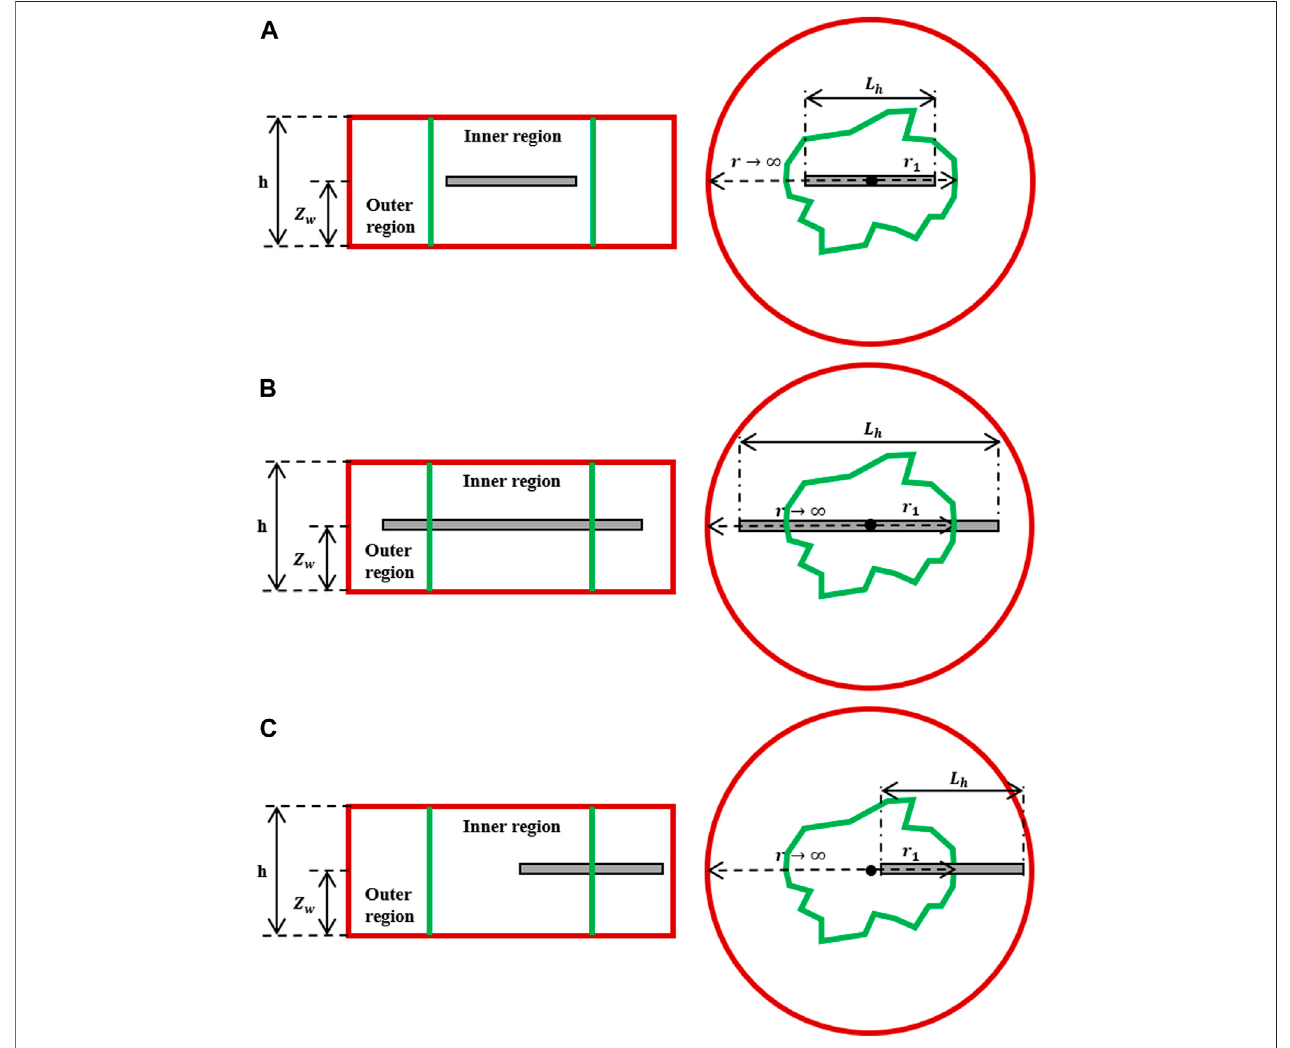
FIGURE 1 | Schematic of a horizontal well. (A) Horizontal well in the inner region. (B) Horizontal well passing through both inner region and outer region on both sides. (C) Horizontal well passing through both inner region and outer region on single side.